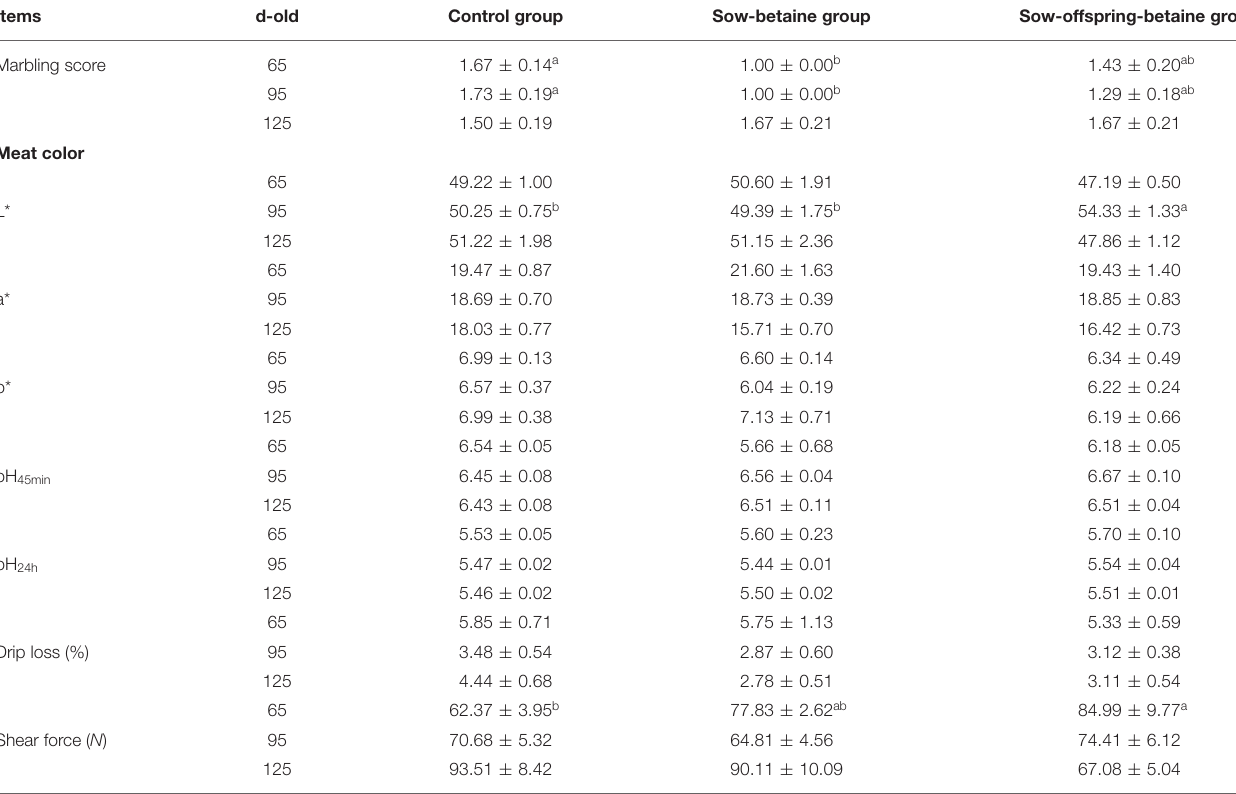
TABLE 2 | Effect of dietary betaine on meat quality of Bama mini-pigs. Items d-old Control group Sow-betaine group Sow-offspring-betaine